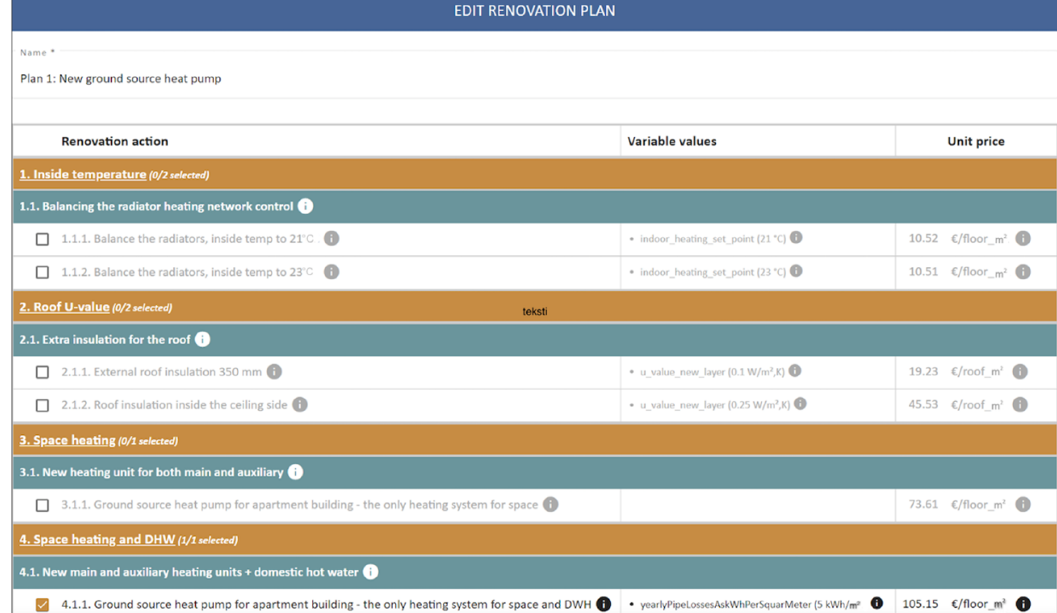
Figure 7. Retrofitting tool GUI: Step 4—Select/Edit retrofitting actions.